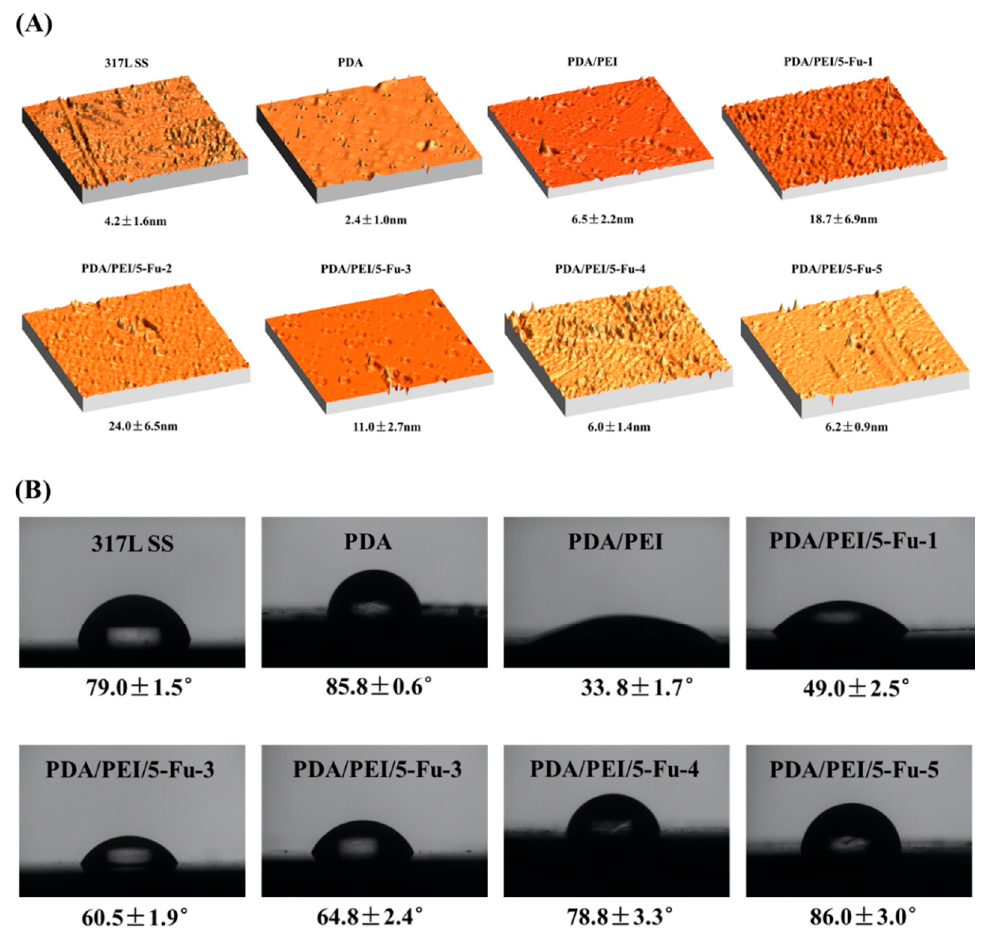
Figure 3. ( A ) Atomic force microscopy (AFM) images and ( B ) water contact measurement of PDA/PEI, PDA/PEI/5-Fu-1, PDA/PEI/5-Fu-2, PDA/PEI/5-Fu-3, PDA/PEI/5-Fu-4, PDA/PEI/5-Fu-5,